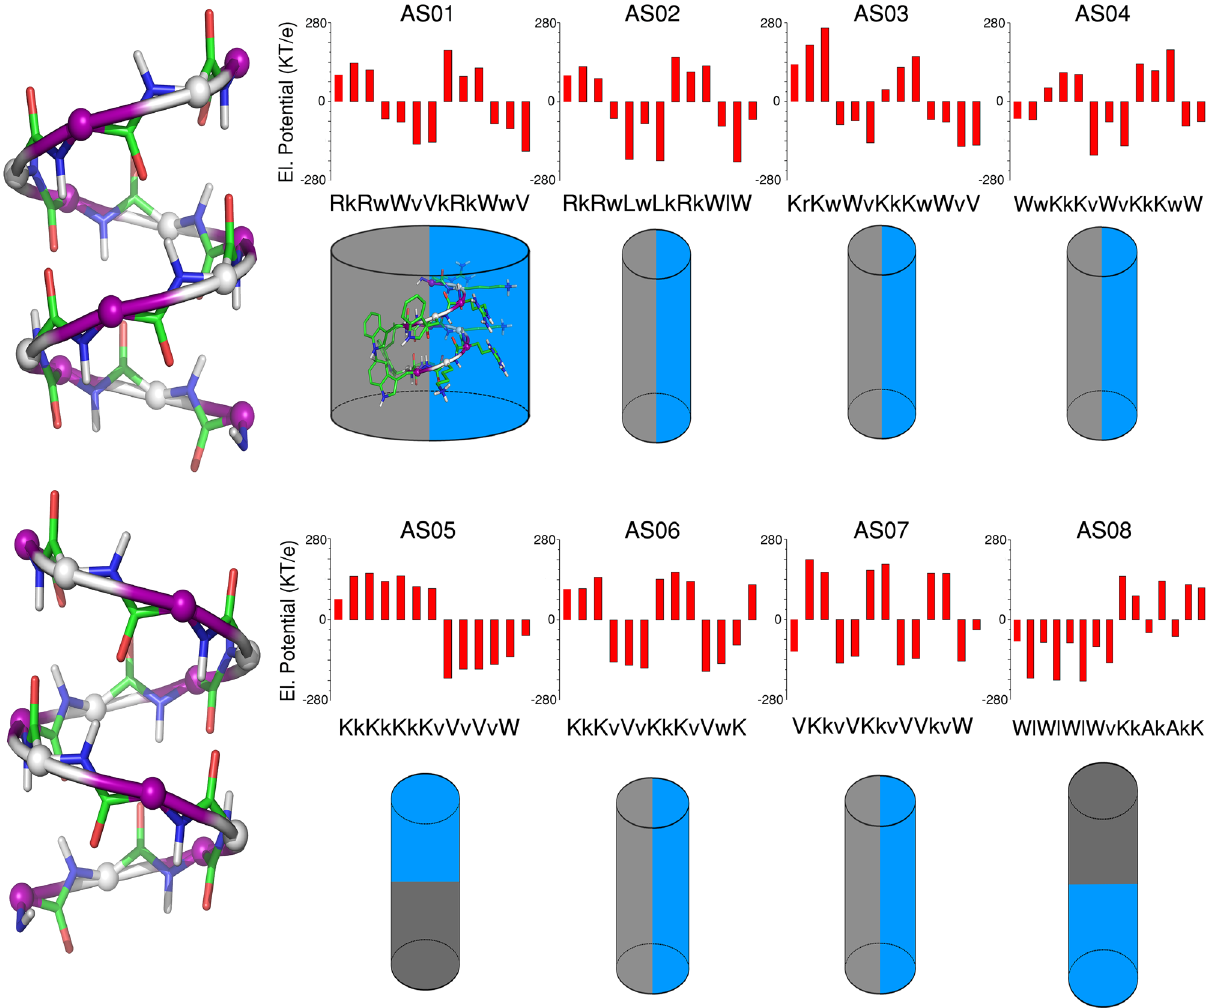
Figure 1. Cylindrical cartoon representation of backbone structure and electrostatic potential of peptide series (AS01–AS08). The electrostatic potential is expressed in KT/e unit. The blue color shows the sequences with cationic side-chains, whereas, the grey color indicates non-polar (hydrophobic) side-chains. Small letter in the sequence represents D-enantiomers of respective amino acids. All the cylinders are having N terminus at the top and C-terminus at the bottom. Right handed and left handed syndiotactic helical molecules with alternating L,D chain stereochemistry is shown as ball and stick diagram. Short range electrostatics of gramicidin beta helix is mutually complementary, with NH and CO bonds with opposite polarity in close proximity. This will improve the overall stability of the molecule, helping to retain the structure and designed amphipathicity while interacting with the membrane. Images of cylinders are made using MS powerpoint, Peptide illustrations using Ribosome (gifted from G D Rose Lab) and Pymol (https ://pymol